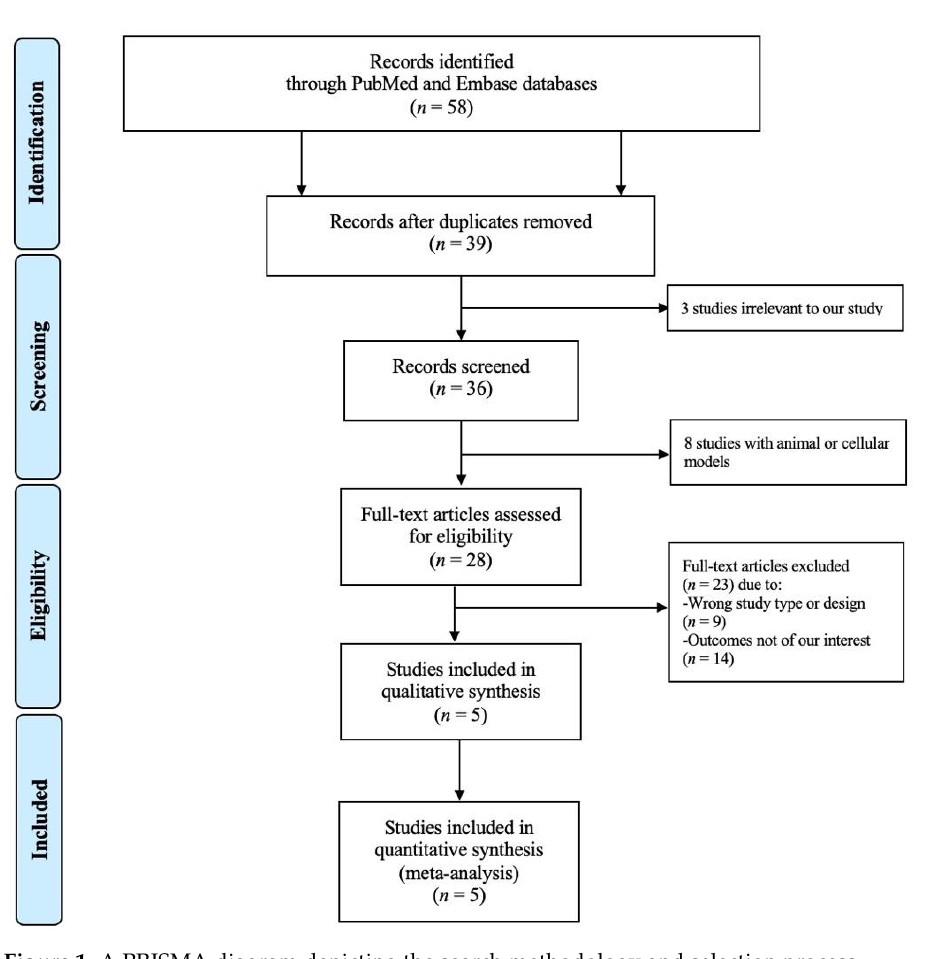
Figure 1. A PRISMA diagram depicting the search methodology and selection process.